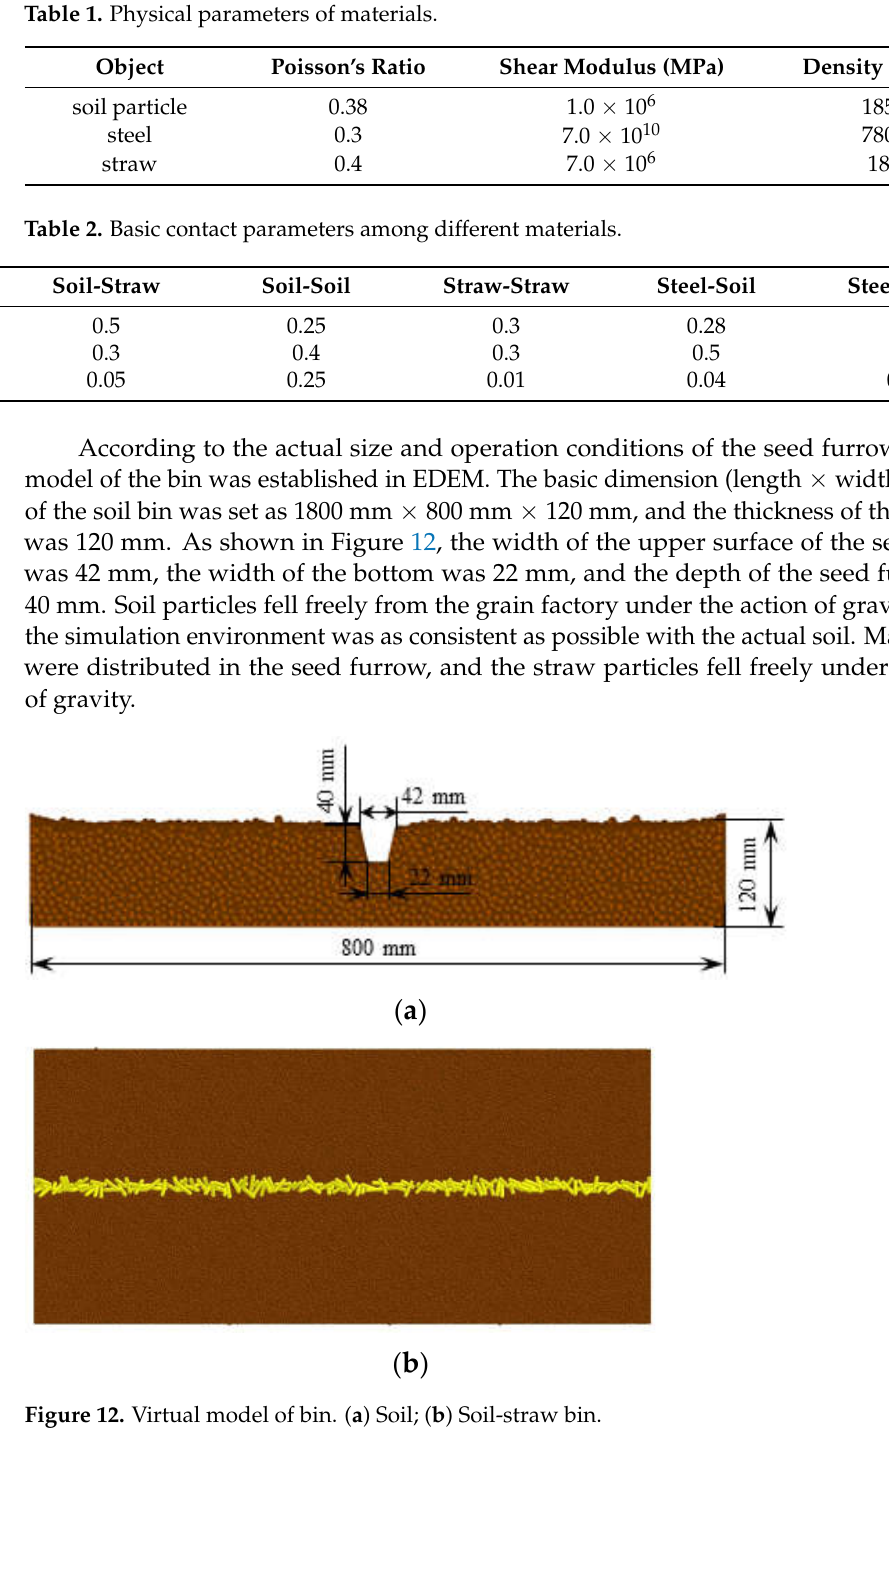
Table 1. Physical parameters of materials.